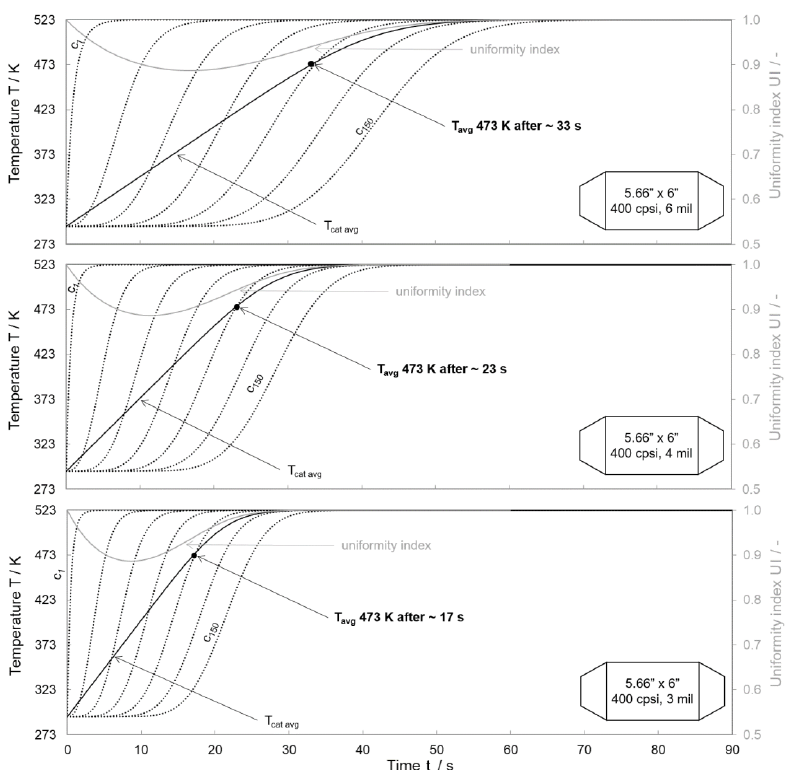
Figure 13. Steady state heat-up of 400 cpsi monoliths at a flow rate of 100 kg/h and 523 K. Energies 2021 , 14 , x FOR PEER REVIEW The range of wall thicknesses for commercially available 600 cpsi substrates delivers similar findings to those of 300 cpsi and 400 cpsi monoliths (see Figure 14). The interplay between heat transfer coefficient, (thermal) mass, and internal surface area results again in the shortest heat-up periods for the least wall thicknesses within the same cell density.